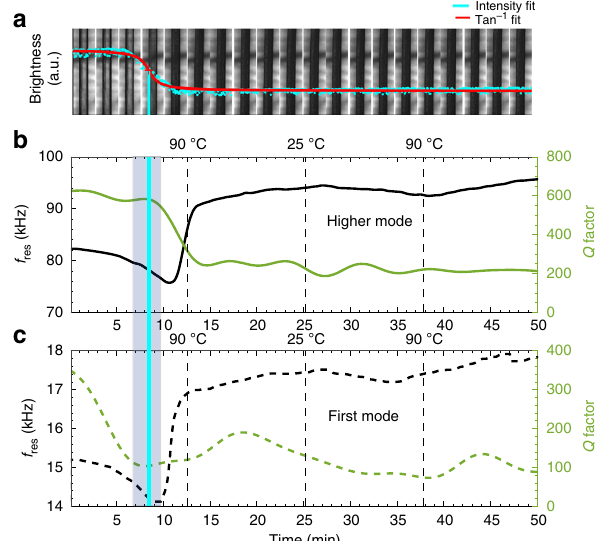
Fig. 5 Mode analysis of a TP MH cantilever. a Optical images showing the dehydration (25 – 90 – 25 – 90 – 25 °C, 5 °C/min), of TP MH particle resonator (1400 μ m × 71 μ m). b , c Tracking of two fl exural modes of vibration (15 kHz and 82 kHz) of the same TP MH particle during two heating and cooling cycles. The shaded regions in the fi gures highlight the dehydration transitions of TP MH.